Question: Name the type of graph shown.
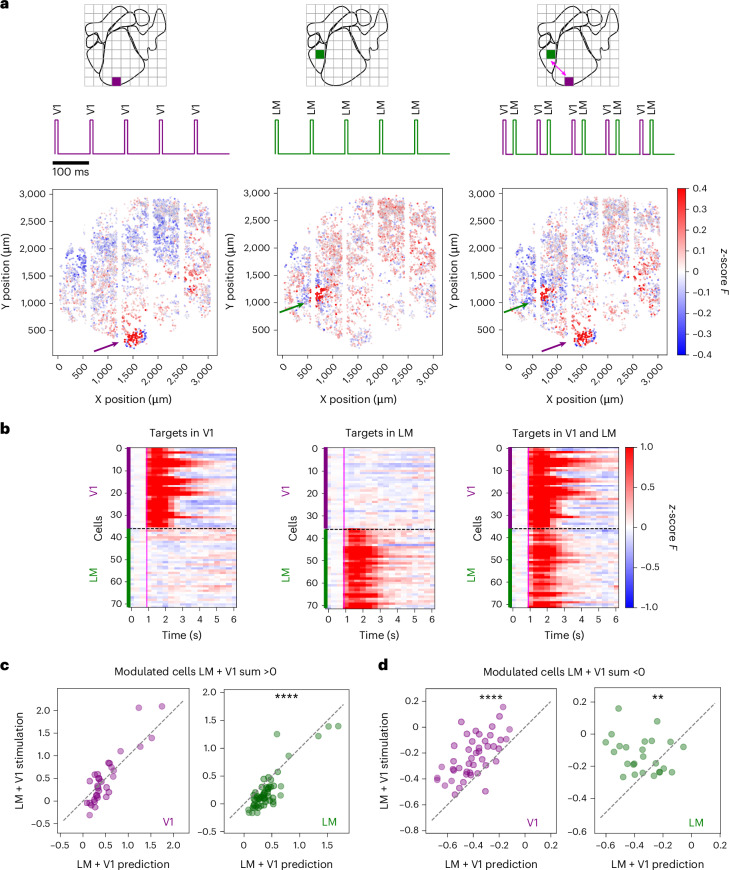
Answer: scatter